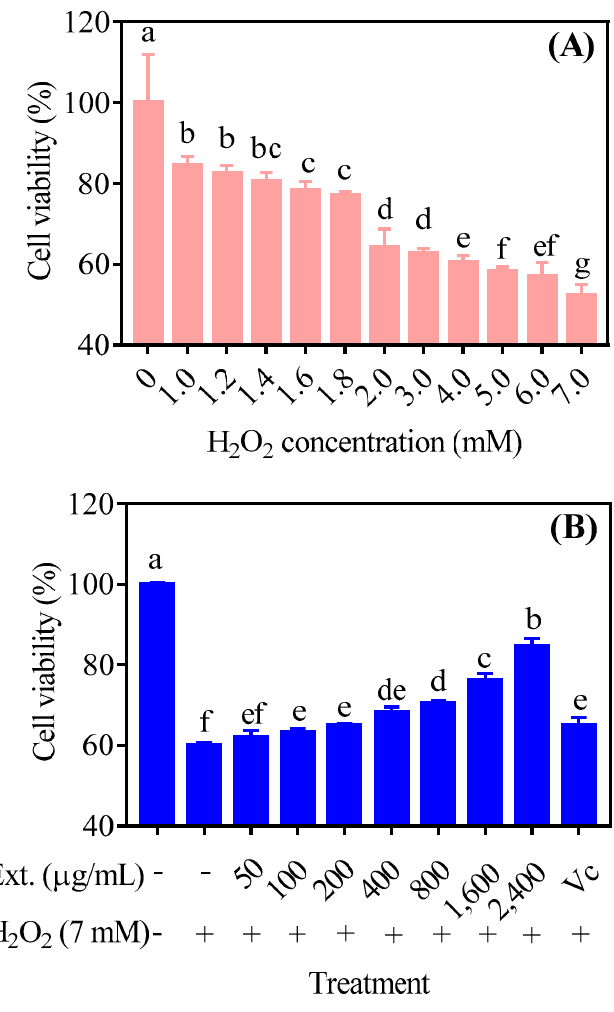
Figure 1. H 2 O 2 and chrysanthemum extract on cell viability. ( A ) LO2 cells were treated using different concentrations of H 2 O 2 for 4 h and the cell viability was determined by MTT assay. ( B ) LO2 cell was pretreated with different concentrations of chrysanthemum extract for 12 h and H 2 O 2 for another 4 h. Cell viability was determined by MTT assay. Ext.: chrysanthemum extract, Vc: vitamin C. Three independent experiments were performed. The lower case letters indicate significant difference at p < 0.05 for different treatments.